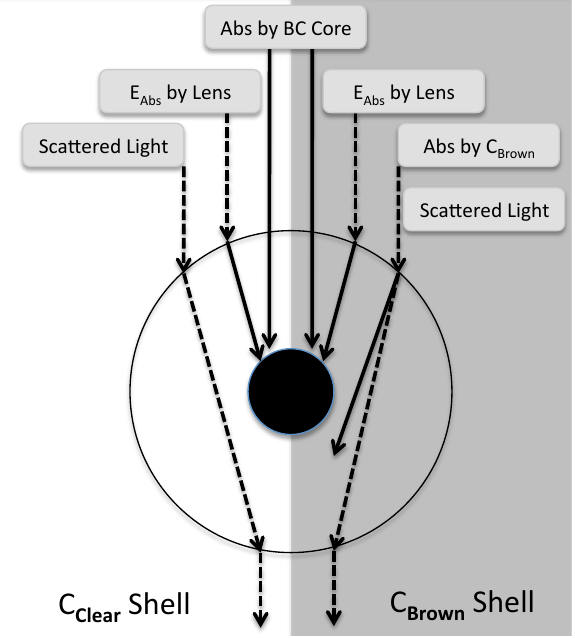
Fig. 1. Schematic of the effect of C Clear and C Brown shells on BC absorption.